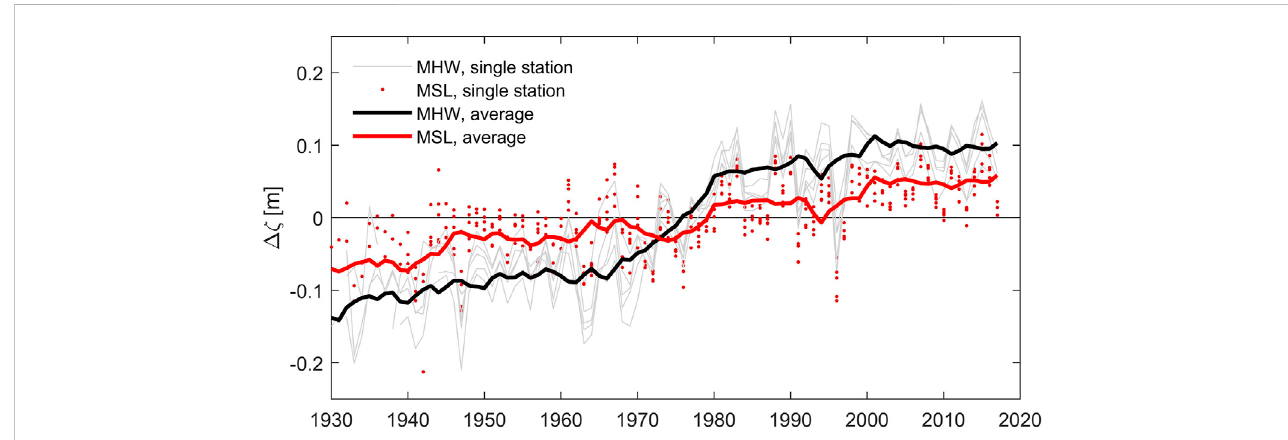
FIGURE 10 Mean sea level (MSL, in red) and mean high water (MHW, in black) anomalies in the Wadden Sea, based on the average of fi ve long-term tidal gauges throughout the Dutch Wadden Sea (Den Helder, Harlingen, Kornwerderzand, Vlieland Port, West-Terschelling) starting observations around 1930 (data from the Dutch Ministry of Public Works). MHW is de fi ned as the annual average of all high waters for a speci fi c year; the MHW anomaly (per station) is de fi ned as MHW minus the long-term average MHW (over the period 1930 – 2020). MSL is de fi ned as the annual mean water level;the anomaly is computed similar to that of MHW. The average MHW and MSL anomalies are smoothed with a 3 years running mean for visualization purposes.